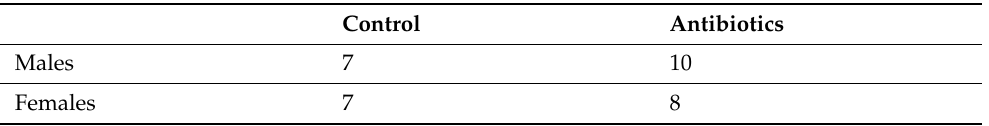
Table 1. Animal numbers per treatment group for fentanyl intravenous self-administration in antibiotic treatment.